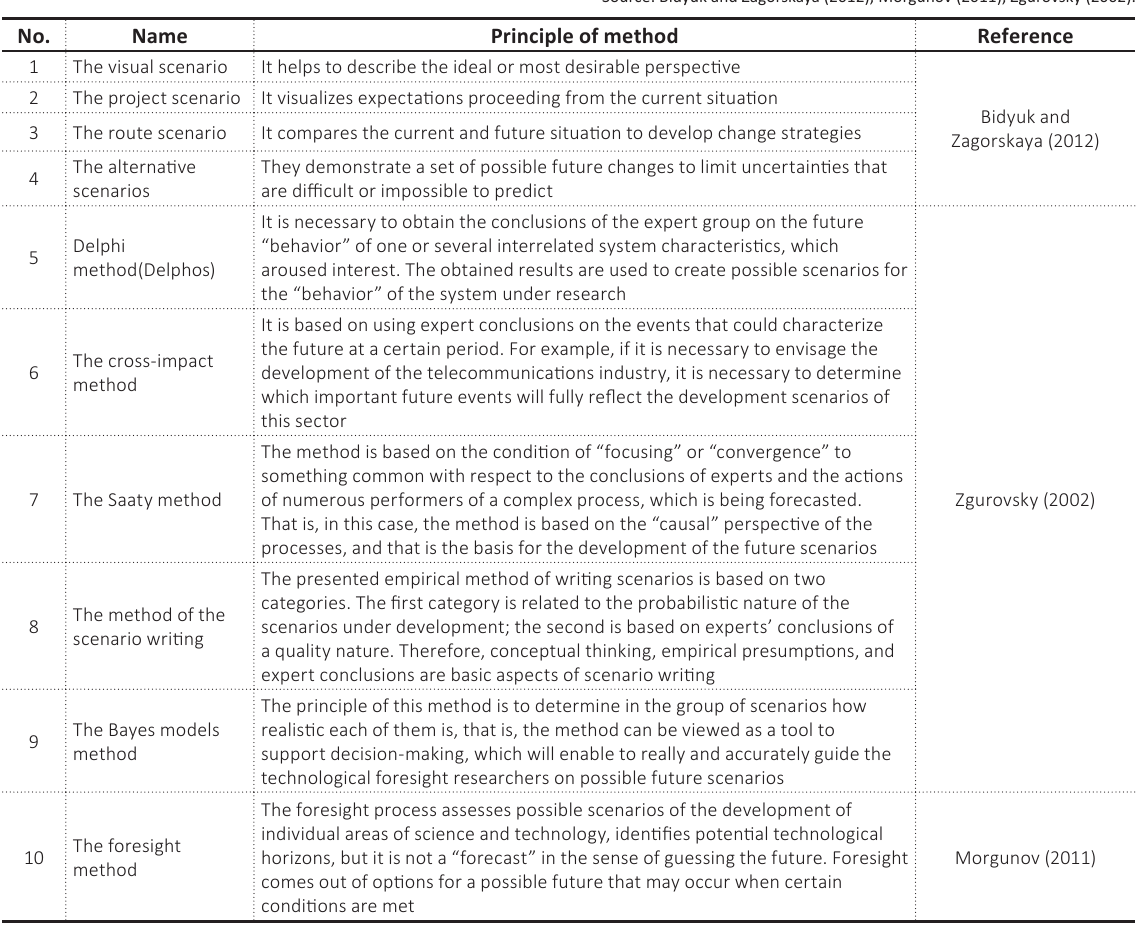
Table 1. The main methods and types of scenario